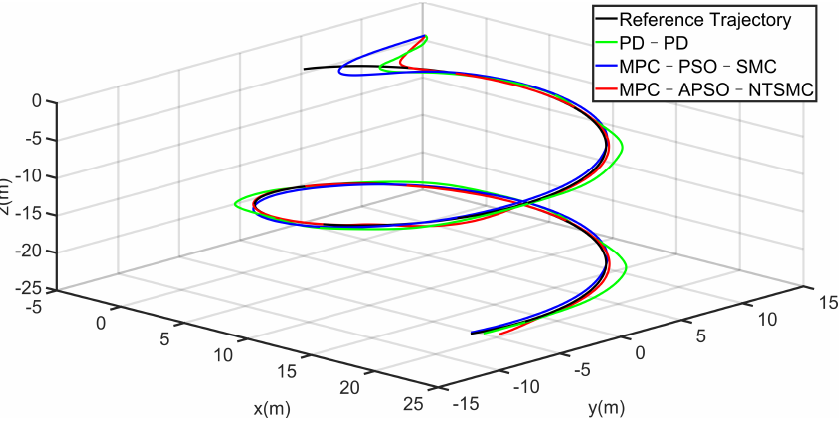
Figure 9. AUV spiral trajectory tracking without disturbance for Case 1.